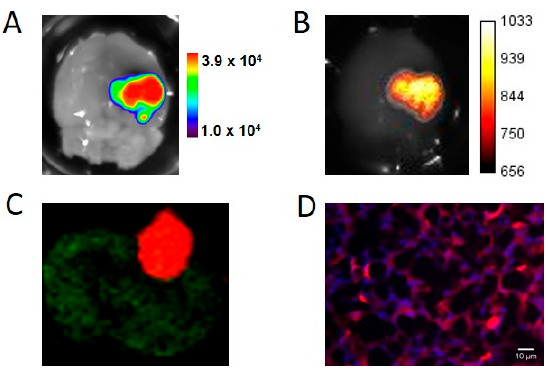
Figure 4. Ex vivo imaging and histology of U87-iRFP+-Fluc+ brain tumors. An excised brain was sequentially imaged by BLI ( A ) and FRI ( B ) to reveal tumors; ( C ) Cryosection of the brain tumor was scanned for fluorescence using the Odyssey scanner showing iRFP fluorescence at 700 nm (red) and brain autofluorescence at 800 nm (green); ( D ) Fluorescence signals of iRFP (red) and nucleus (DAPI, blue) were revealed using epifluorescence microscopy.